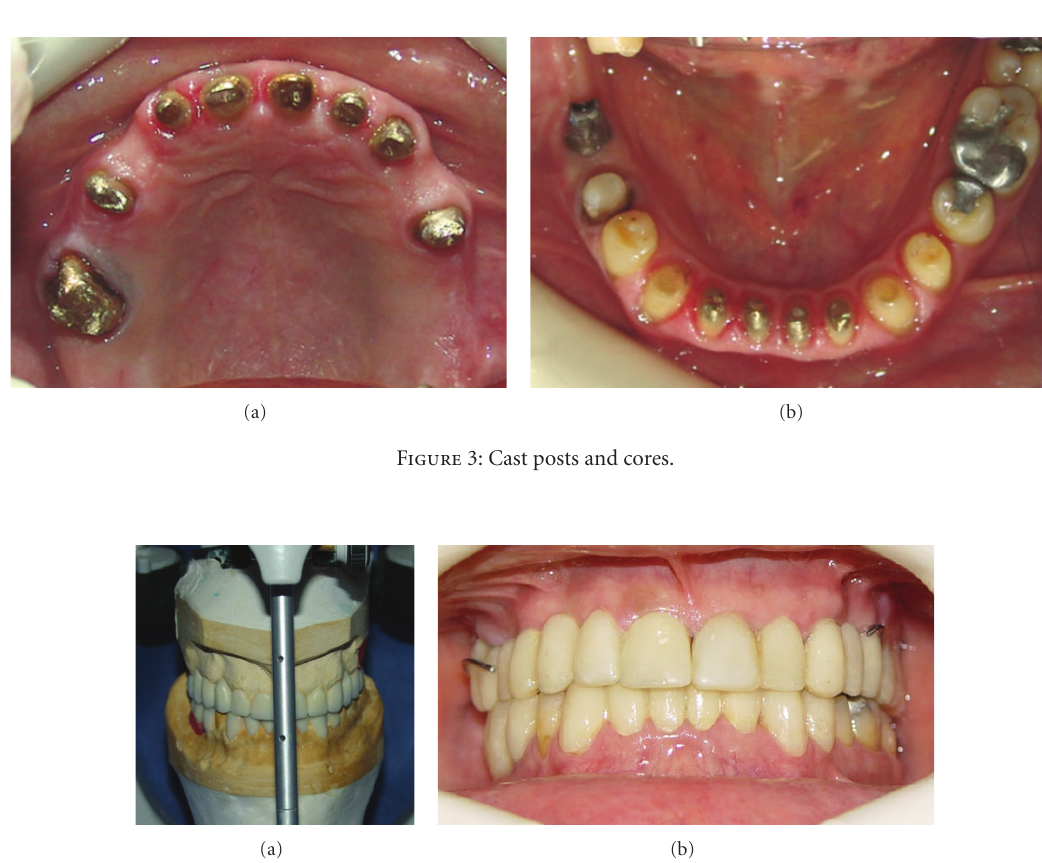
Figure 4: Diagnostic waxup (a); fixed and removable provisional restorations in place